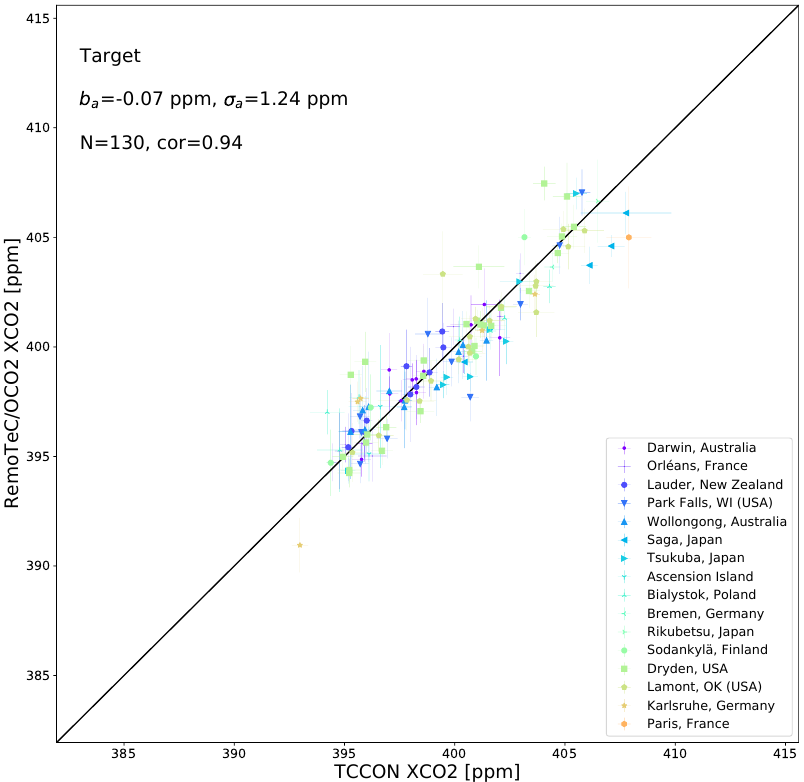
Figure 5. Validation of averaged X CO retrieved from OCO-2 target measurements with collocated TCCON data. The retrieval results shown 2 here are overpass averages of single soundings per station within 2h. The SD of individual TCCON data and that of RemoTeC/OCO-2 retrievals are presented with error bars. The bias ( b a ), SD ( σ a ), number of points ( N ), the Pearson correlation coefficient (cor) and one-to-one line are